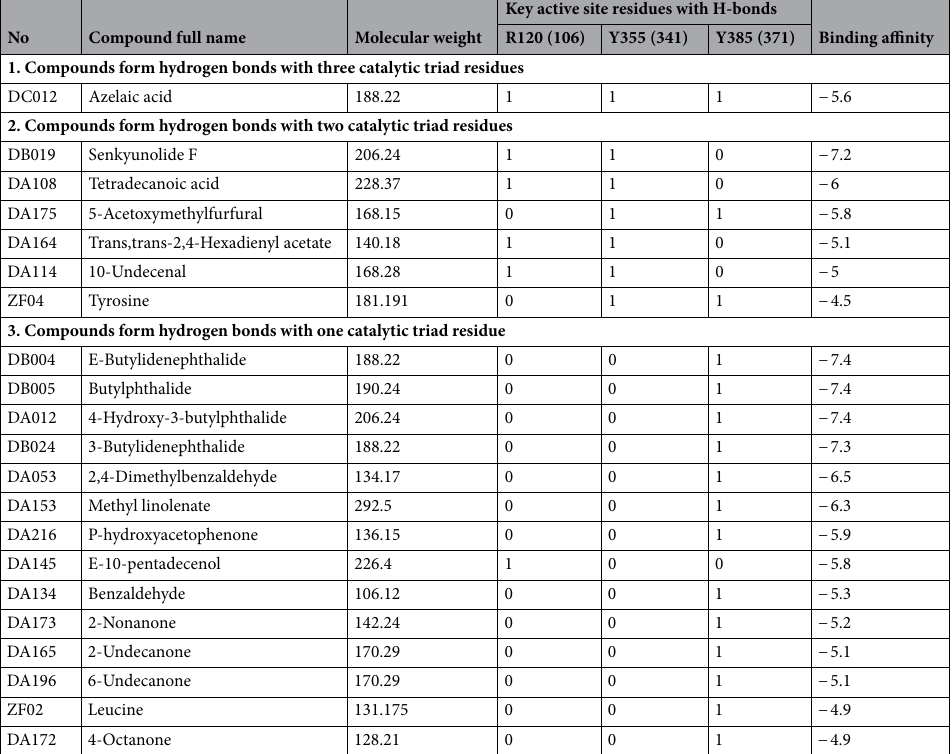
Table 3. Details of compounds from hydrogen bonds with one or more key active site